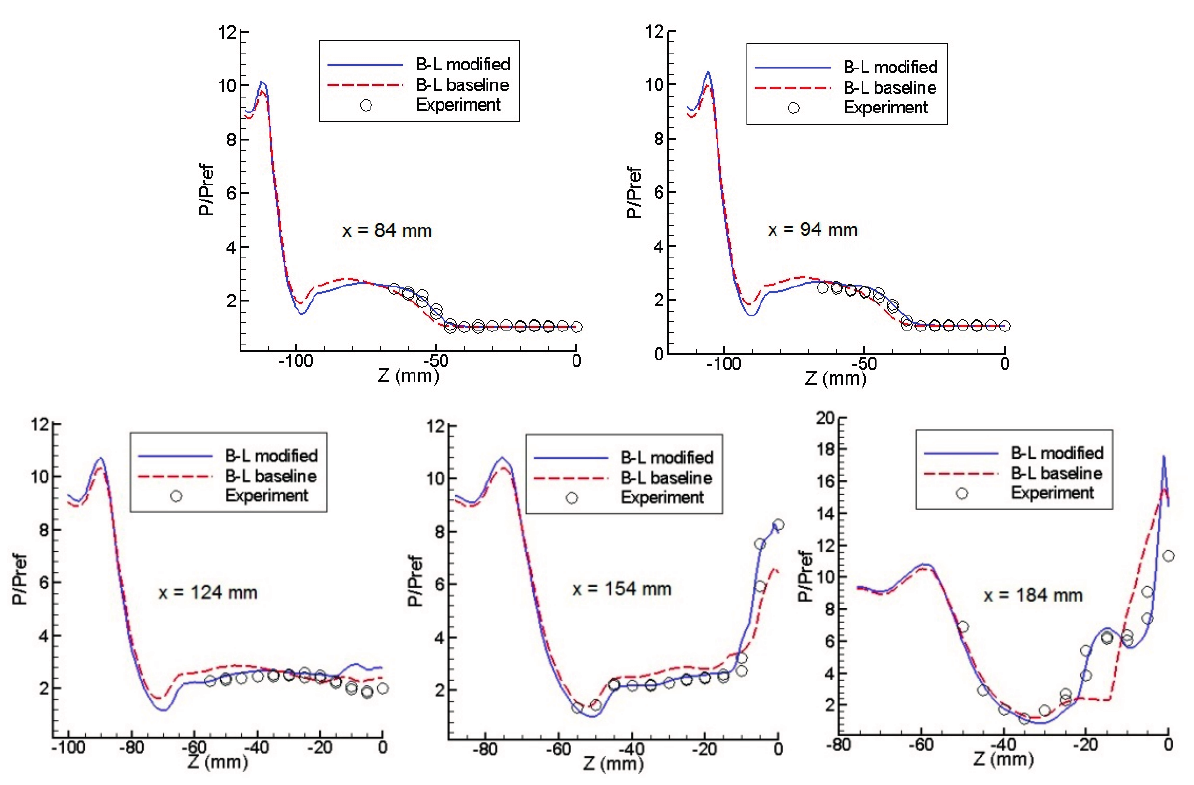
Figure 9. Surface pressure distribution comparison at various cross sections.